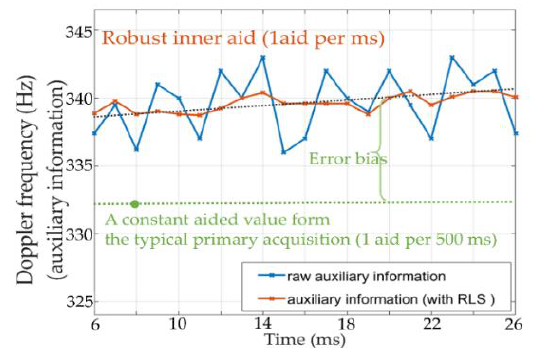
Figure 15. Comparison of a typical and robust aid scheme.